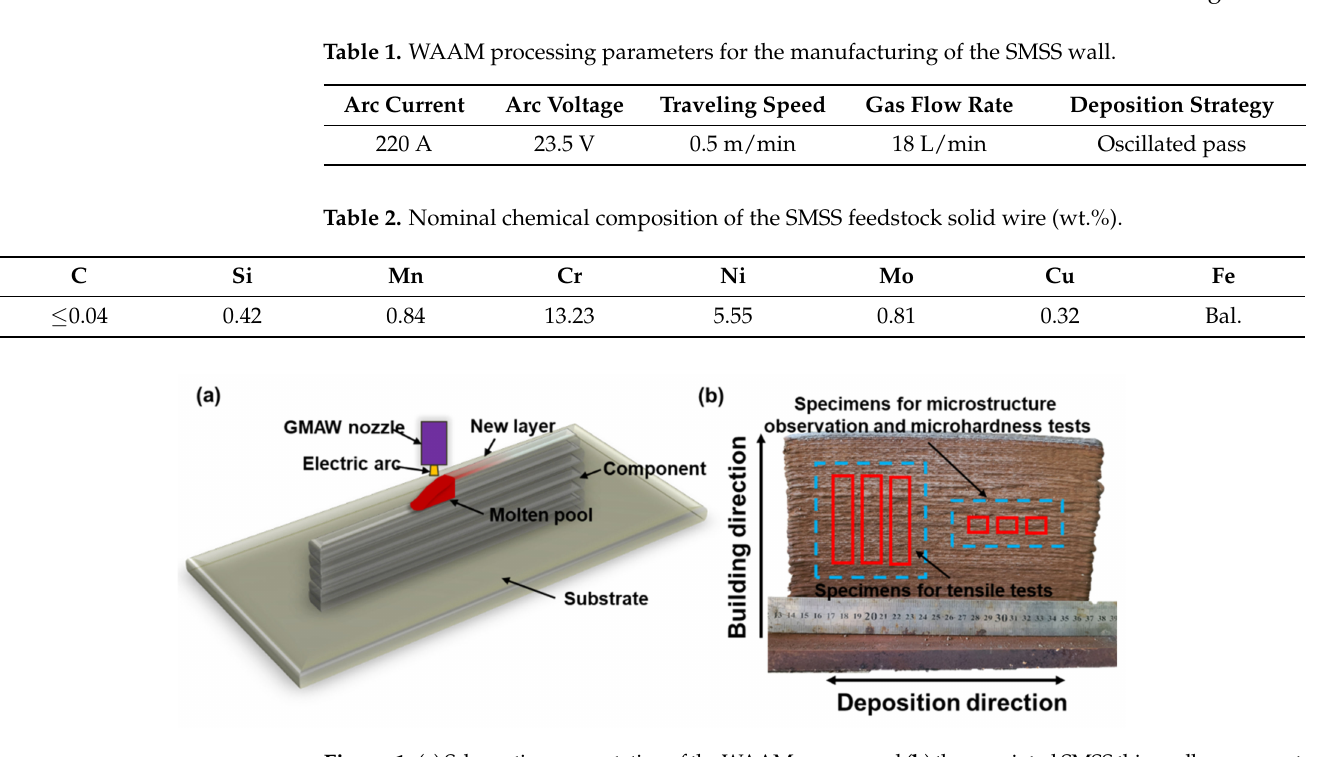
Figure 1. ( a )SchematicrepresentationoftheWAAMprocessand( b